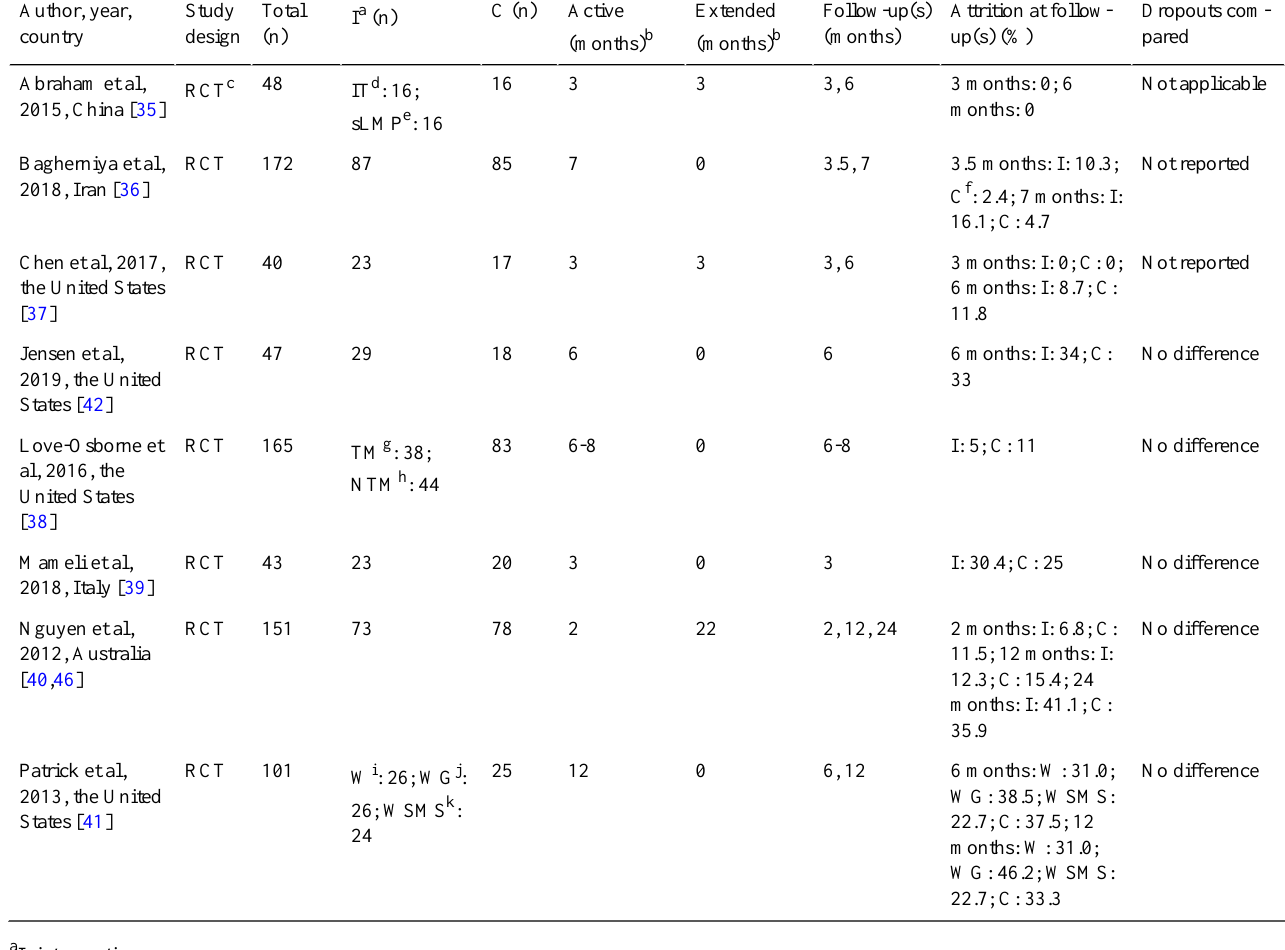
Table 4. Characteristics of included studies